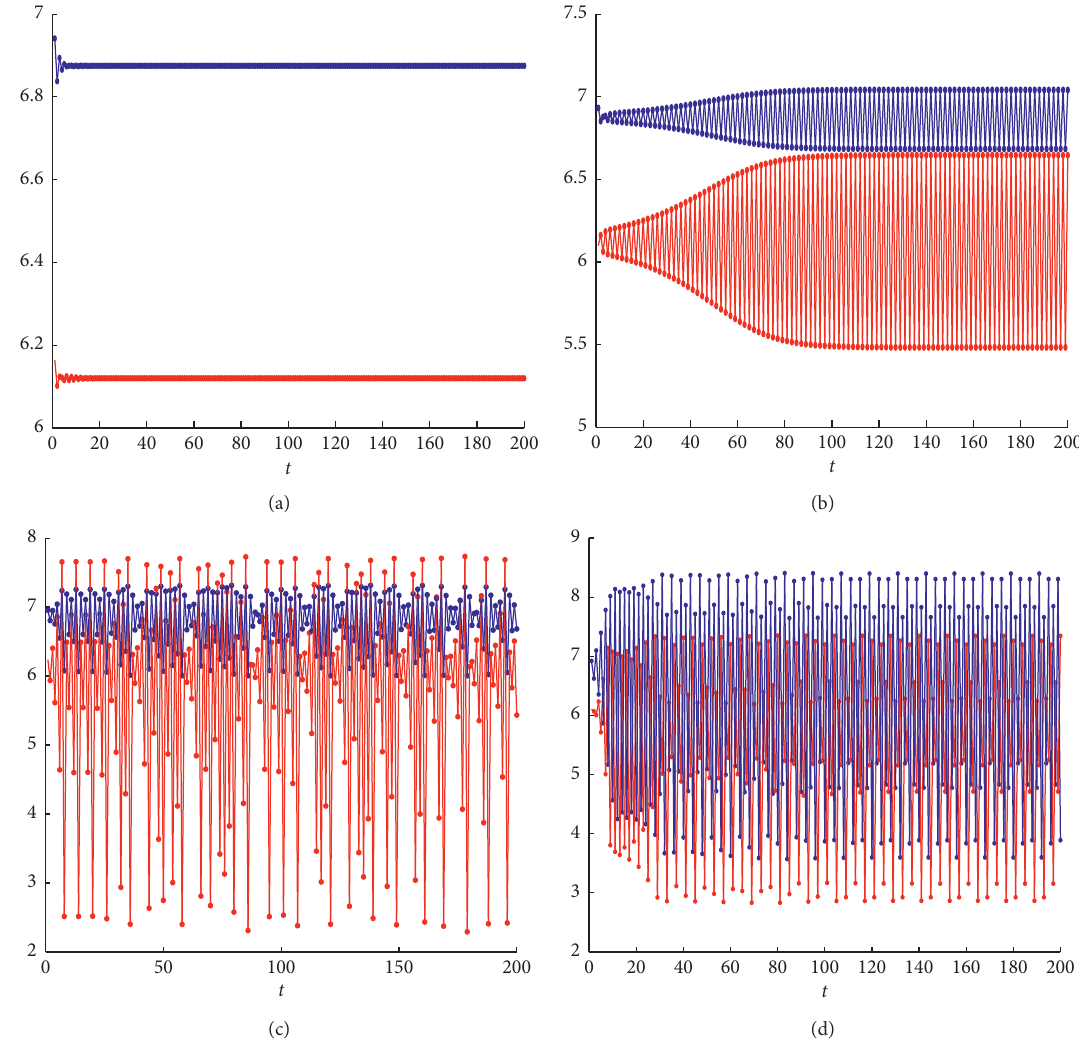
Figure 8: Time series of w (red dot) and p (b) κ w � 0 . 35 , κ p � 0 . 14 , τ � − 0 . 2. (c) κ w � 0 . 445 , κ p � 0 . 14 , τ � − 0 . 2. (d) κ w � 0 . 35 , κ p � 0 . 25 , τ � − 0 .